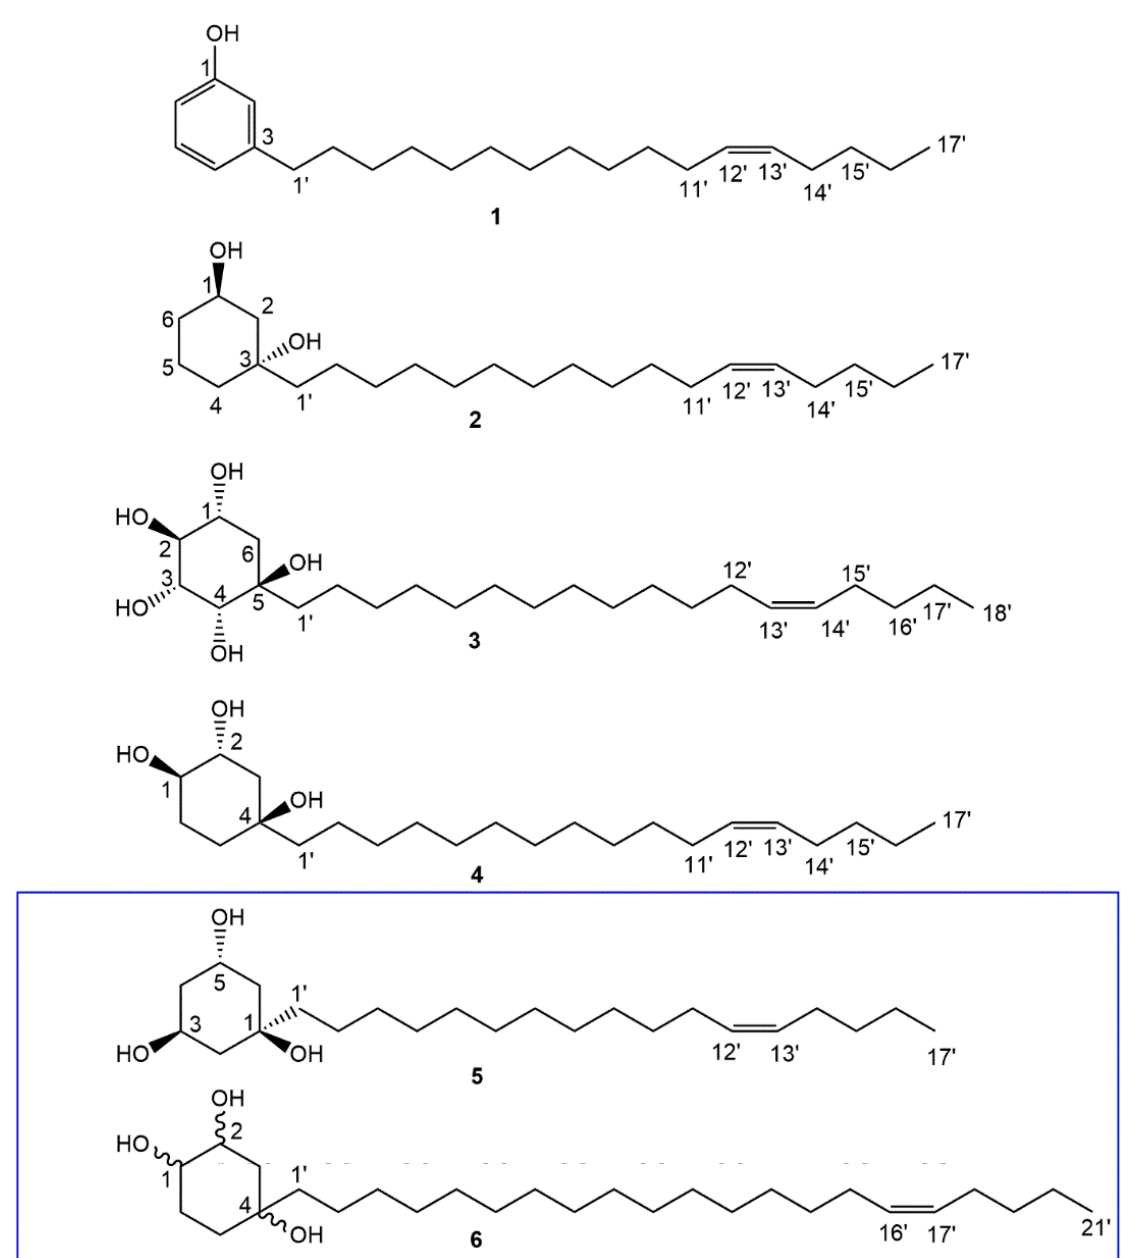
electronic circular dichroism (ECD) (Figure 3), which revealed a high-amplitude positive cotton effect in the regions 230–250 and 295–325 nm. Compound 2 was therefore named